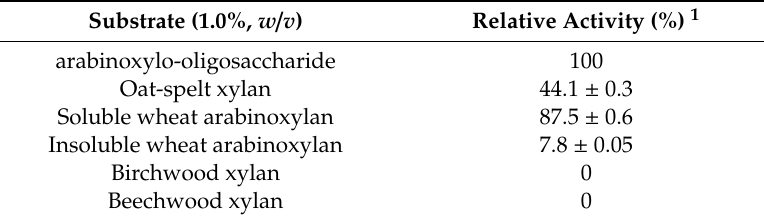
Table 1. Substrate specificity of